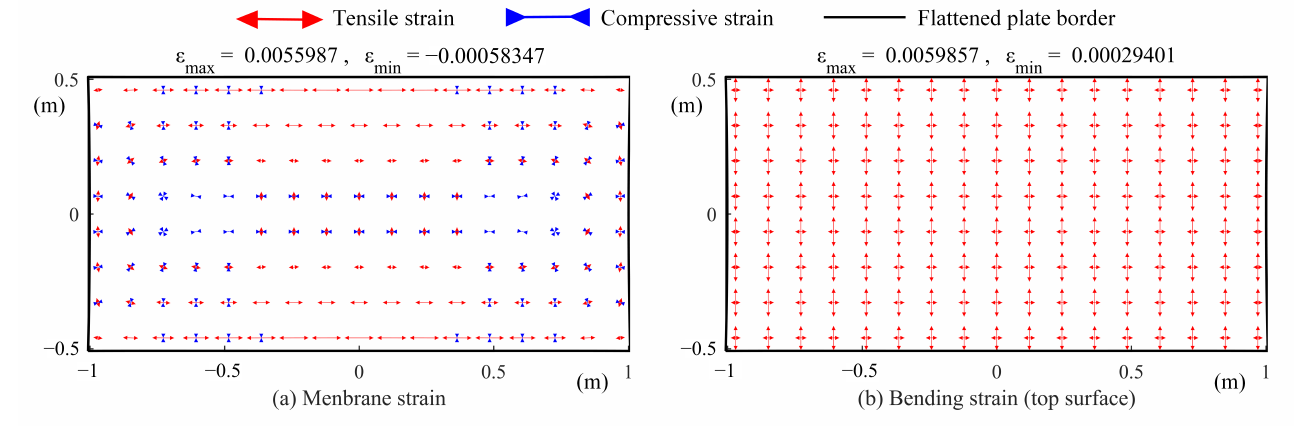
Figure 15. Principal inherent strain distribution desired in forming process ( a ) membrane strain, ( b ) bending strain (top